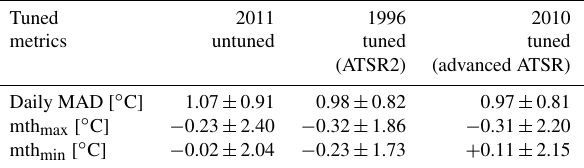
Table 11. Results of the independent evaluation of the tuning pro- cess for non-ice-covered lakes. The spread of differences across lakes is defined as 2 σ . Metrics (explained in Table 4) for the un- tuned year (2011) are compared with those from the first full year of data from along-track scanning radiometers 2 (ATSR2) (1996) and the last year of tuned data from Advanced ATSR (2010). For the untuned year (2011), for each lake, the model is forced with the effective lake depth ( Z d ) , snow and ice albedo ( α) and light extinc- tion coefficient ( κ d ) values determined during the tuning process, shown in the supplement. Units are given in square brackets.